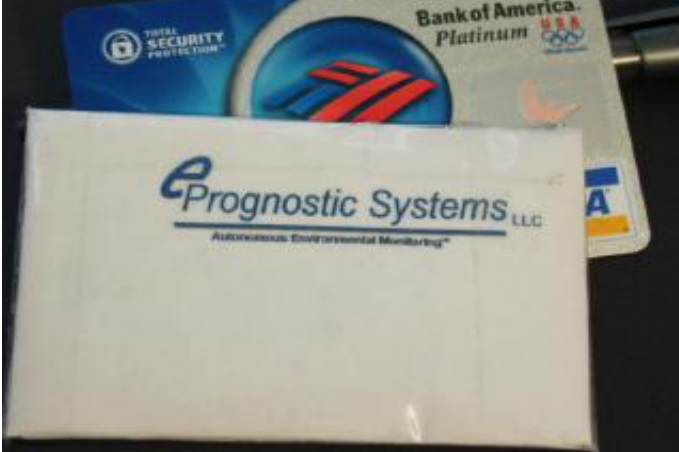
Figure 5. ePrognostic sensor system [17].